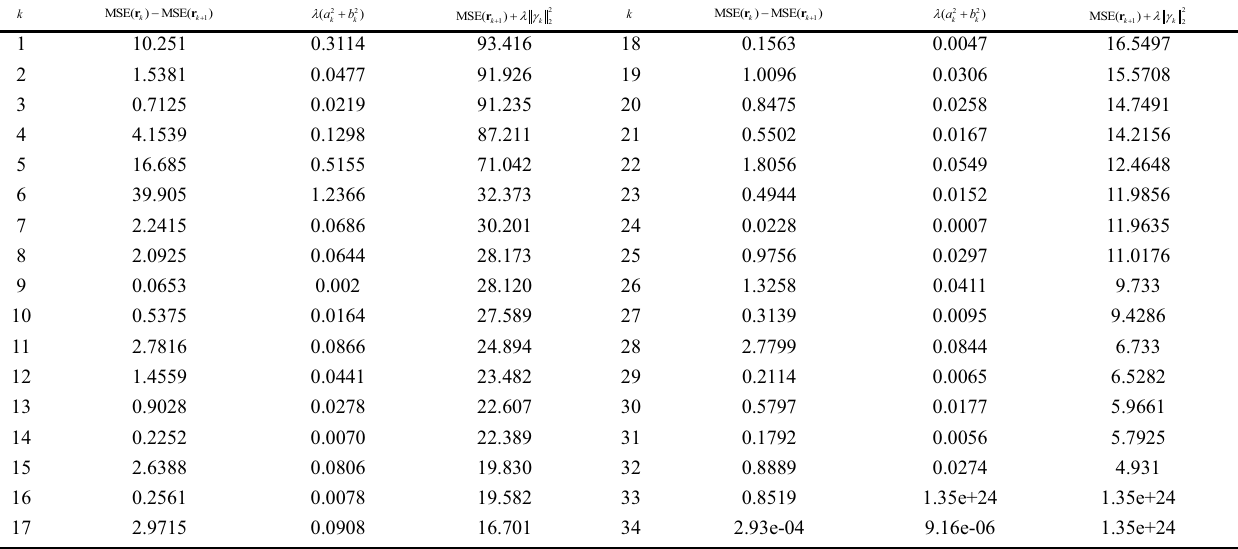
Table 2. Model selection calculation